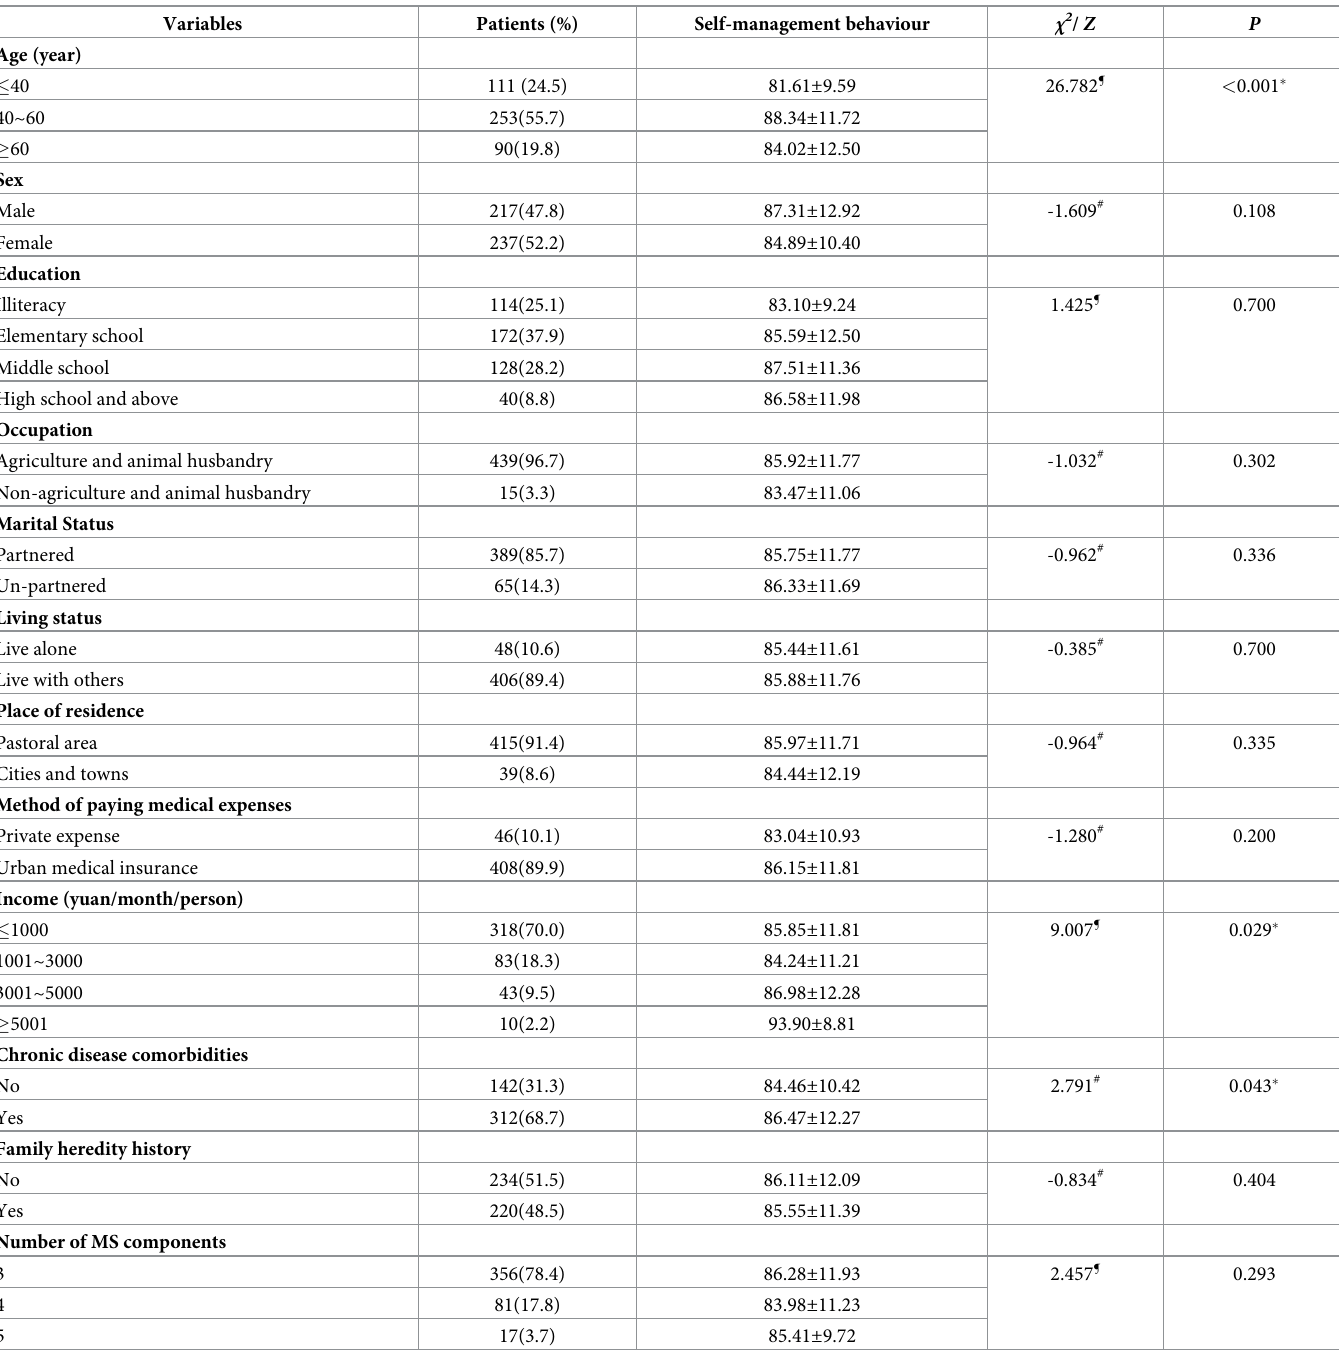
Table 1. Univariate analysis of general characteristics and self-management behaviour of Kazakh MS patients ( n =